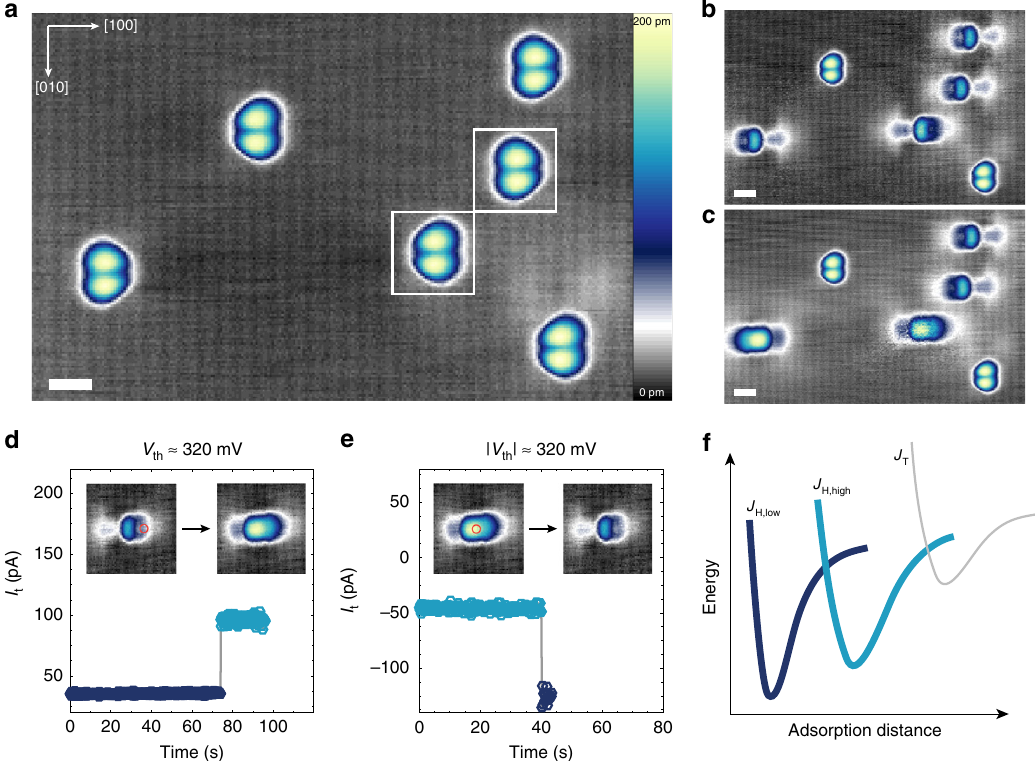
Fig. 1 Adsorption and switching of Co on BP. a Six Co species on BP as deposited at T < 5 K ( V s = − 400 mV, I t = 20 pA, scale bar = 1 nm). Boxed atoms show species related through mirror plane along [010]. b Four atoms from a have been switched into J H,low ( V s = − 400 mV, I t = 20 pA, scale bar = 1 nm). c Two atoms from b have been switched into J H,high ( V s = − 400 mV, I t = 20 pA, scale bar = 1 nm). d Switching characteristics from J H,low to J H,high with V = 420 mV and e J J V = − 680 mV. Approximate threshold biases for switching ( V s H,high to H,low with s during the switching sequence. The inset images showing before and after con fi gurations are 4 nm × 4 nm in size. f Schematic representation of adsorption energy curves for Co species on